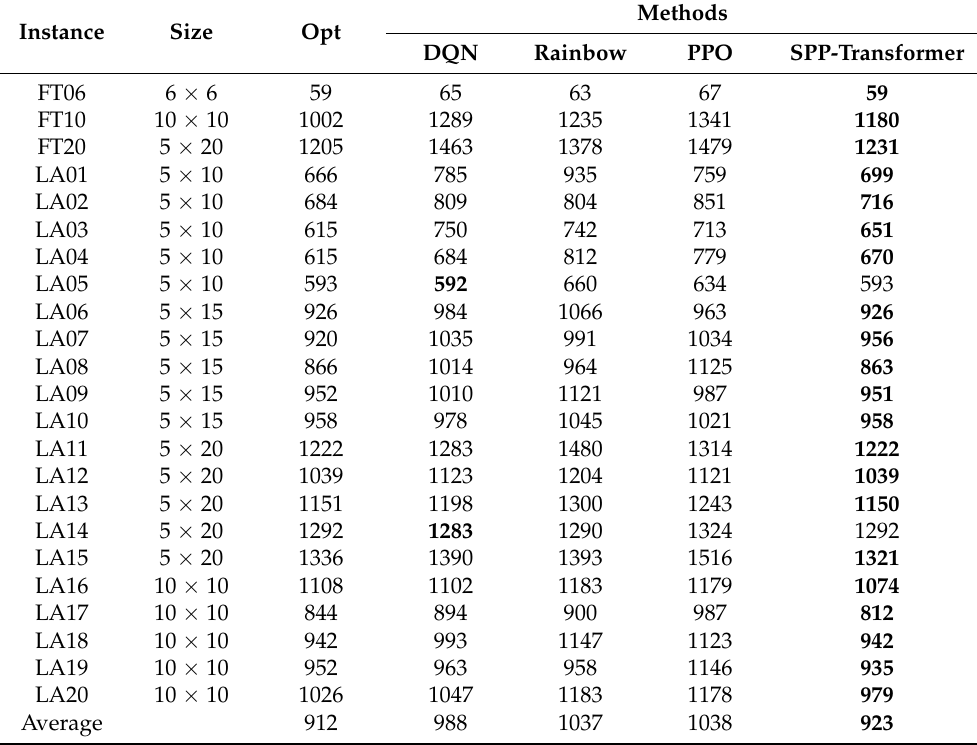
Table A7. The comparison between RL methods and SPP-Transformer on